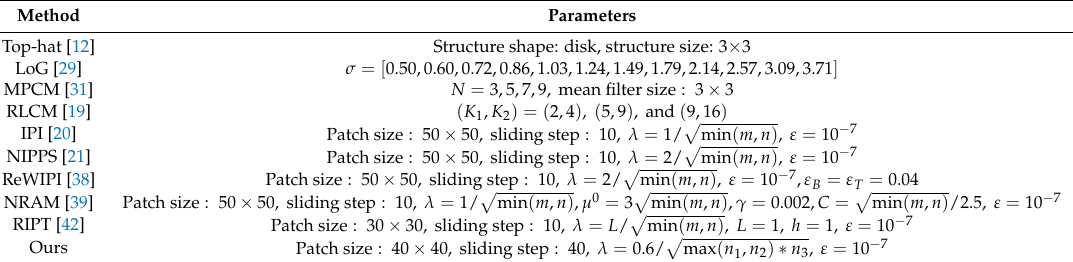
Figure 8. The 24 real scenes used in the experiments. For the sake of visualization, all of the images are changed to the same size. Table 3. Detailed parameter settings of the 10 tested methods.